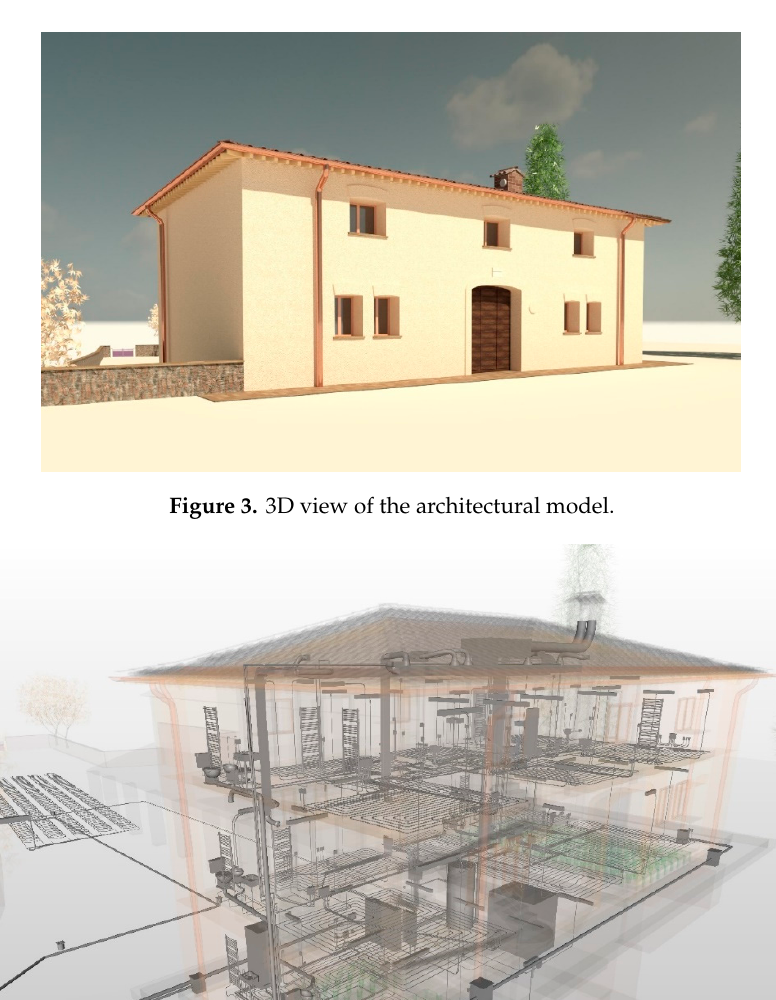
( c ) Figure 2. View of the case study building from the back side: ( a ) before the refurbishment; ( b ) during the refurbishment; ( c ) after the refurbishment. As a result of the recent interventions, the case study building is the very first building certified by means of the LEED (Leadership in Energy and Environmental Design)-consistent protocol Green Building Council Historic Building™ (GBC HB) [32] in the world, for the restoration and sustainable redevelopment of historic buildings. It was awarded the Gold Certification. This type of environmental certification represents a key tool for improving energy efficiency, environmental quality, rational use of resources, and design innovation, together preserving cultural value, allowing greater transparency on energy uses and environmental management in buildings. 2.2. HBIM Model for Energy Systems In order to implement a multidisciplinary and integrated approach, the model of the case study building is developed in the BIM design authoring platform Revit (Autodesk) [33]. This procedure, although rather complex, allowing the creation of the architectural model (Figure 3) and the MEP model (Figure 4) in the same platform. In the parametric 3D models, the technical characteristics of building components and systems are embedded in the geometry. Therefore, the files of the different models are linked together, using the manage section and the manage links command, since they are set using the same reference system with fixed coordinates. Moreover, elements’ initial costs can be